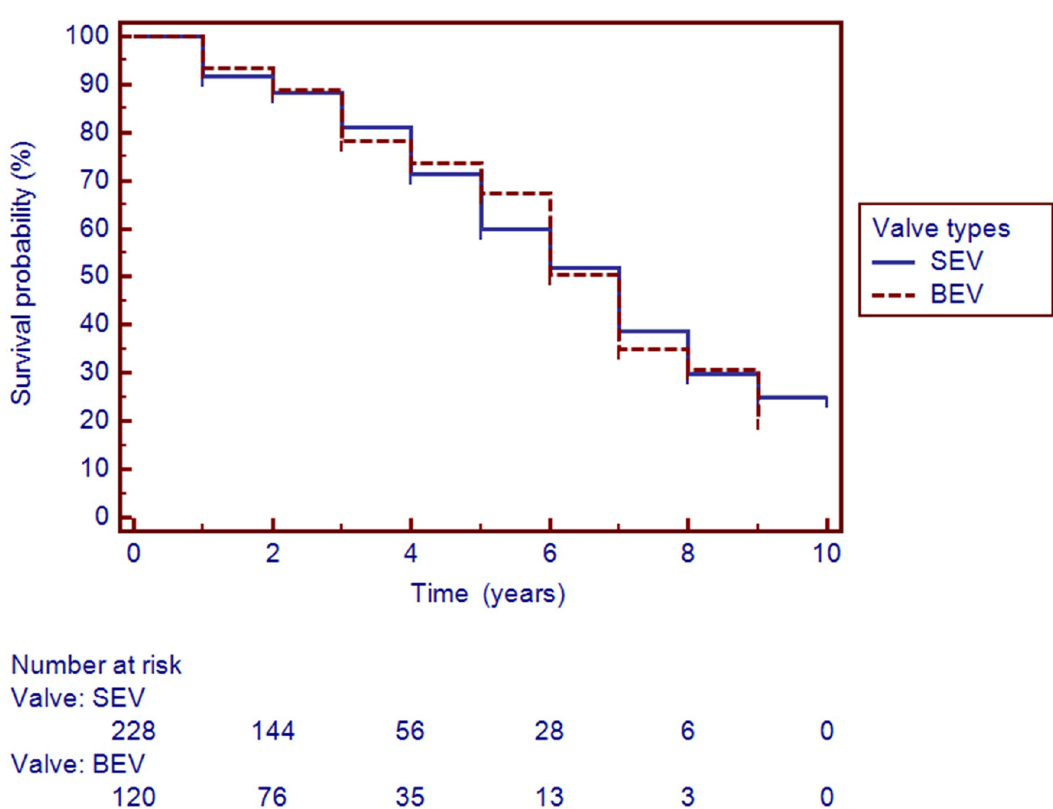
Fig 4. Kaplan Meir curve based on all cause mortality for patients underwent TAVI, showing no difference in survival between the two TAVI types during ten years follow up. SEV = Self Expandable Valve; BEV = Balloon Expandable Valve.